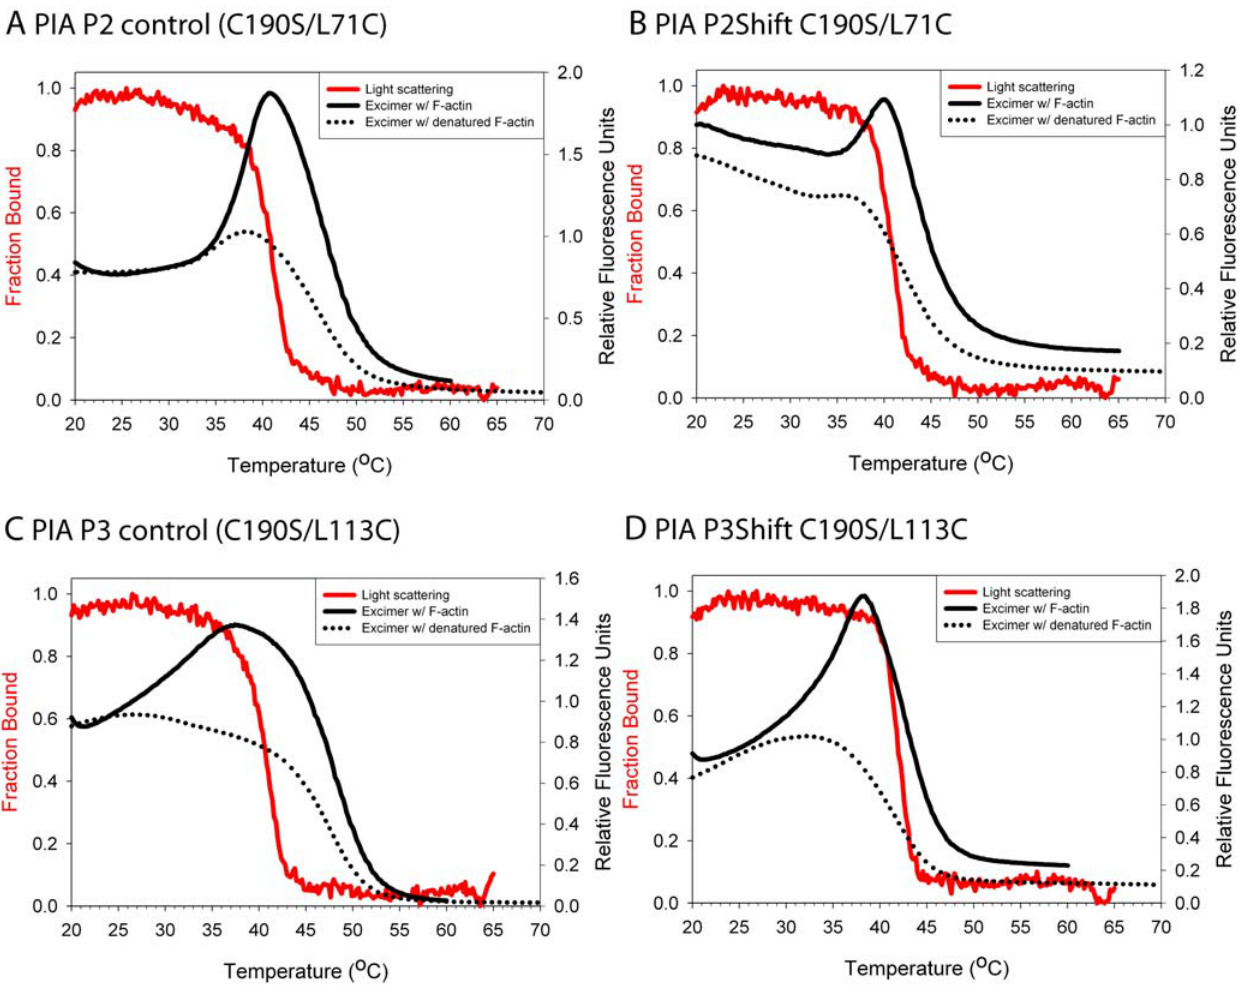
Figure 5. Excimer fluorescence of PIA-labeled and light scattering of unlabeled P2 and P3 mutants. A. P2 control (C190S/L71C) B. P2Shift C190S/L71C C. P3 control (C190S/L113C). D. P3Shift C190S/L113C. Light scattering (red solid line and left axis with red label) was conducted with unlabeled tropomyosin due to interference from excimer peak in light scattering experiments with labeled tropomyosin. Excimer fluorescence (right axis) in the presence of actin (black solid line) and absence of actin (black dotted lines). Buffer conditions and the experimental procedure are as described for Figure 4. The P2Shift and P3Shift mutations locally stabilize the interaction with actin.